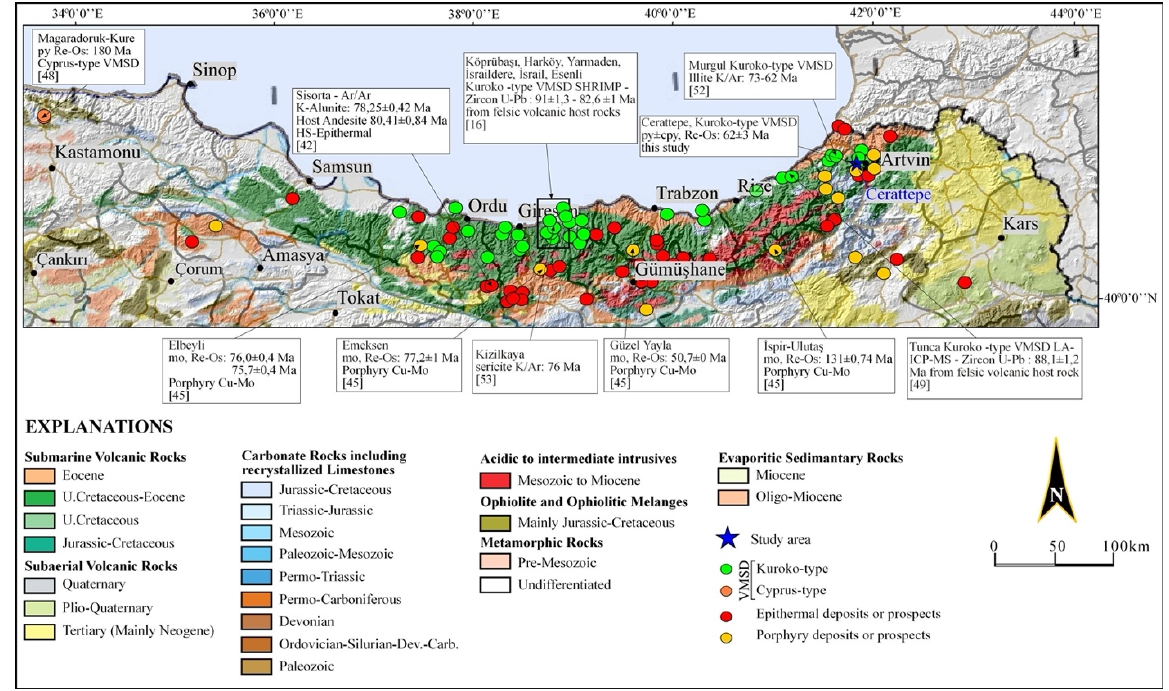
Figure 12. Geological map with continuous SRTM topography surface and distribution of the VMS, Epithermal, and porphyry Cu-Mo deposits and prospects of North Eastern Turkey with emphasis on host-rock lithology. U-Pb, Re-Os, K-Ar and Ar/Ar ages of selected deposits, and location of Cerattepe VMS deposit, host-rock lithology is after [17].